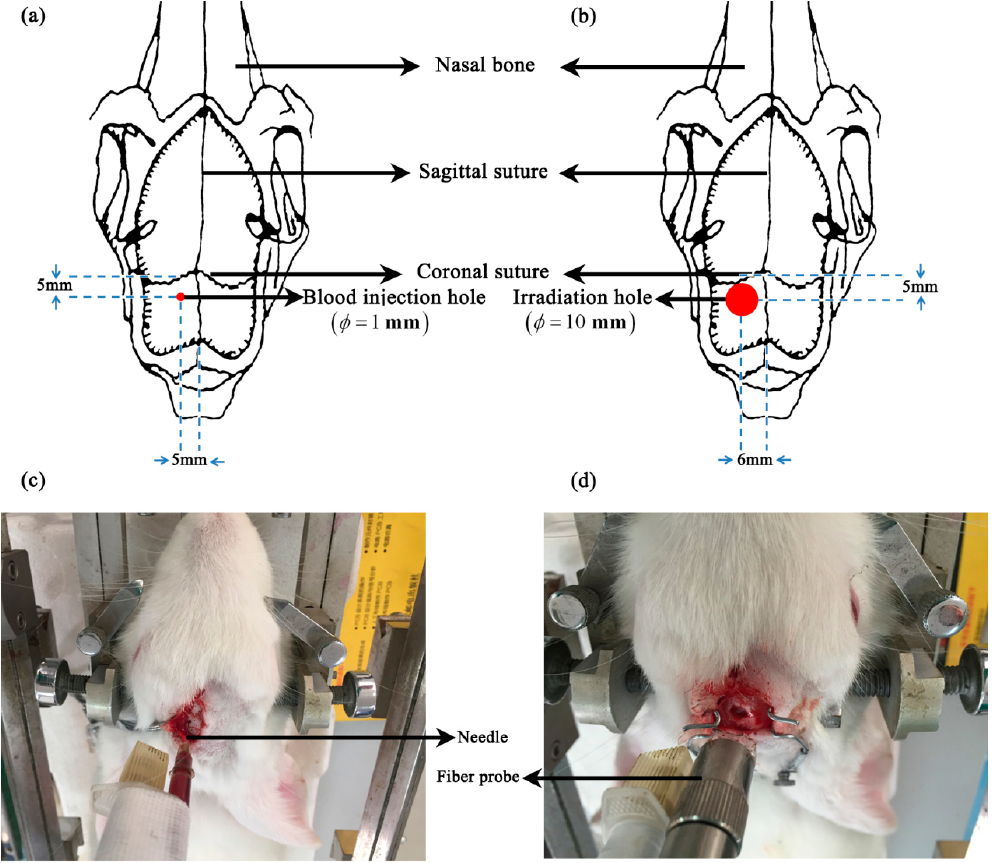
Figure 1. Establishment of the intracerebral hemorrhage and ischemic models. ( a , c ) The hemorrhagic model obtained with the autologous blood injection method. ( b , d ) The ischemic model obtained with the photothrombotic method.